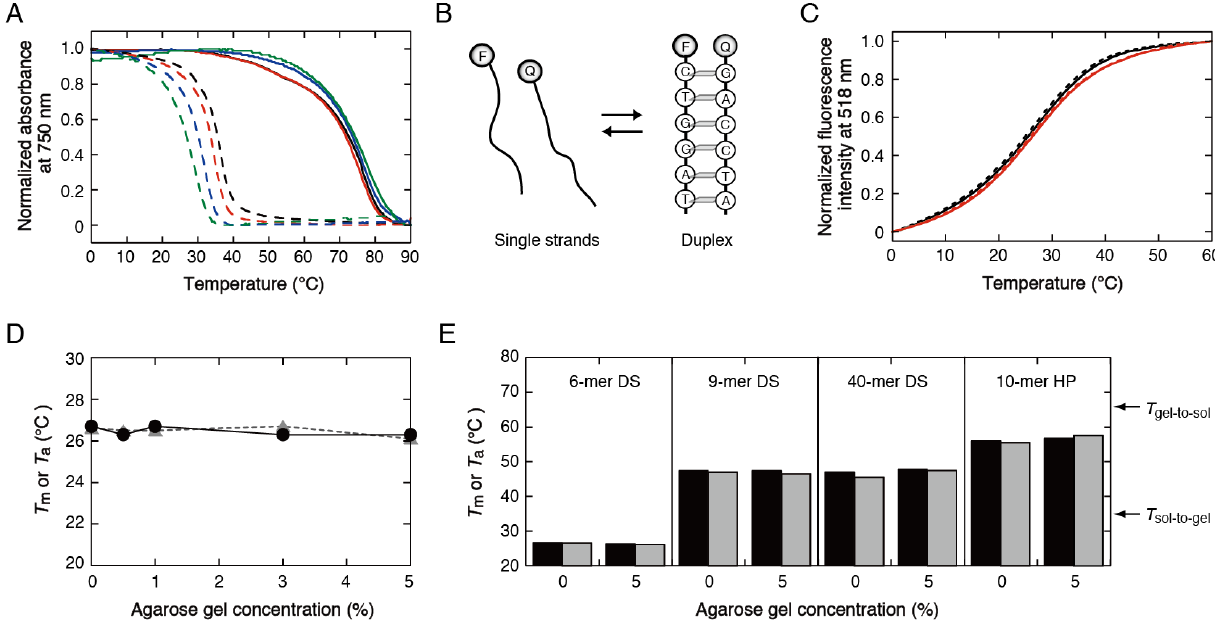
Figure 1. ( A ) Heating and cooling curves (solid and dotted lines, respectively) of agarose gels at 5% (black), 3% (red), 1% (blue), or 0.5% (green). ( B ) Equilibrium for the duplex formation of 6-mer DS by complementary single strands bearing a fluorophore, F, or a quencher, Q. ( C ) Melting and annealing curves (solid and dotted lines, respectively) of 6-mer DS in the 5% agarose gel (red) and the solution (black). ( D ) The T m (black circles) and T a (gray triangles) values of 6-mer DS in agarose gels at various concentrations. The values at 0% represent the temperatures obtained in the solution. ( E ) The T m (black bars) and T a (gray bars) values of DNA structures in the solution (represented as 0%) and the agarose gel at 5%.